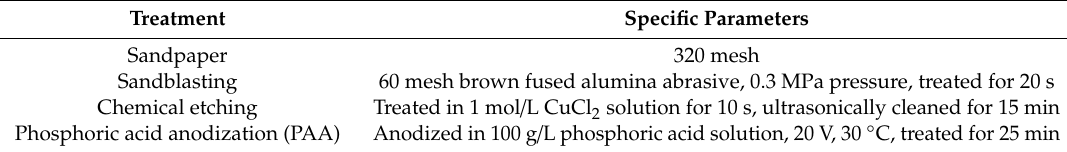
Table 2. Process parameters of four treatments.